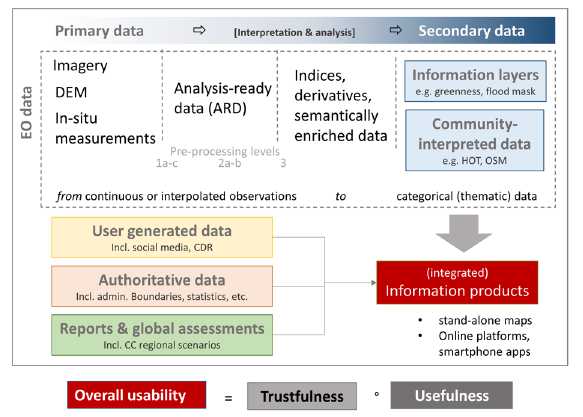
Figure 1 . Data and information products. Data quality